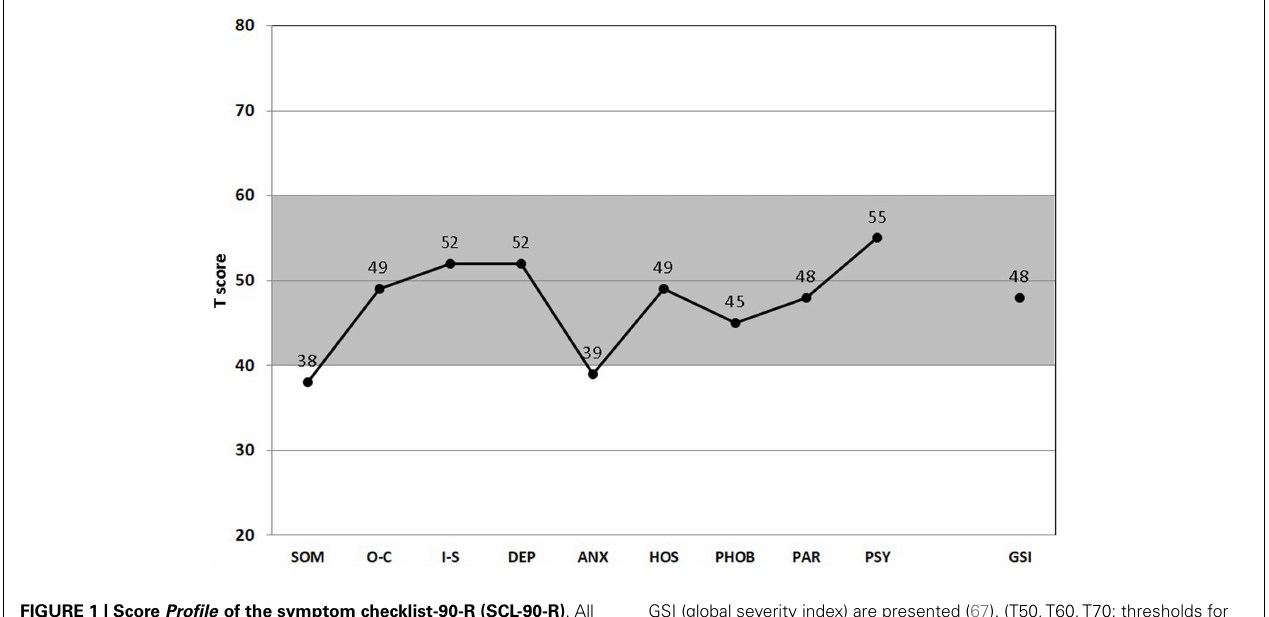
FIGURE 1 | Score Profile of the symptom checklist-90-R (SCL-90-R) . All nine subscales (SOM, somatization; O–C, obsessive–compulsive; I-S, interpersonal sensitivity; DEP, depression; ANS, anxiety; HOS, hostility; PHOB, phobic anxiety; PAR, paranoid ideation; PSY, psychoticism), and the